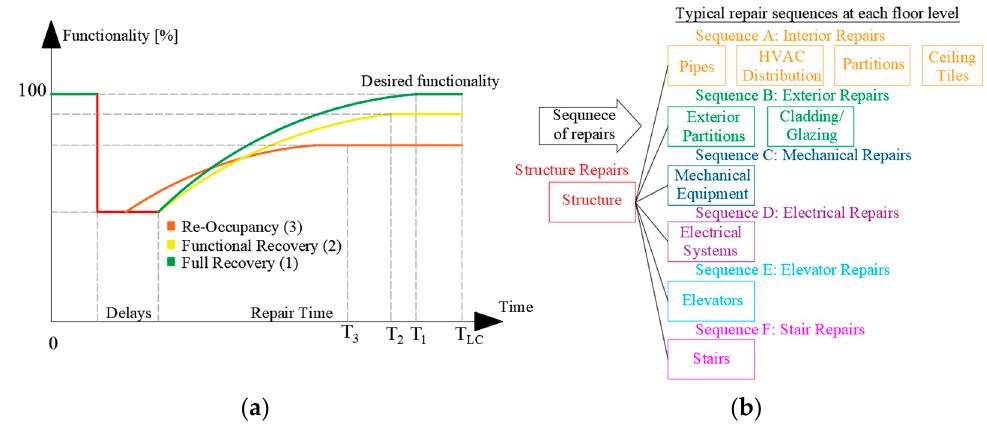
Figure 3. REDi recovery framework: ( a ) recovery states and ( b ) repair sequence, adapted from [1].